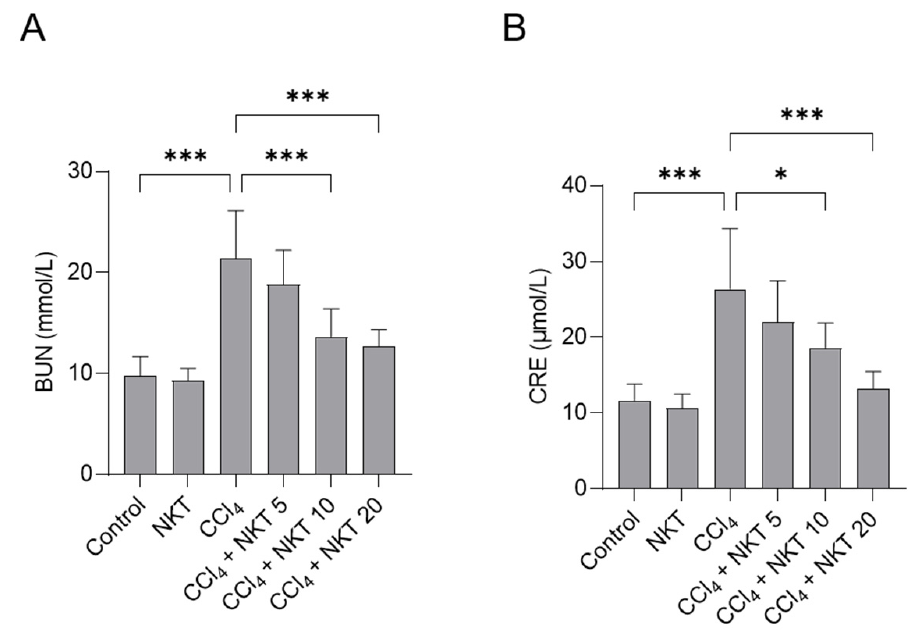
Figure 3. NKT pre-treatment improves CCl 4 exposure -induced the increases of serum BUN ( A ) and CRE ( B ) levels. Data reported as mean ± S.D. ( n = 8 in each group). * p < 0.05, and *** p < 0.001.